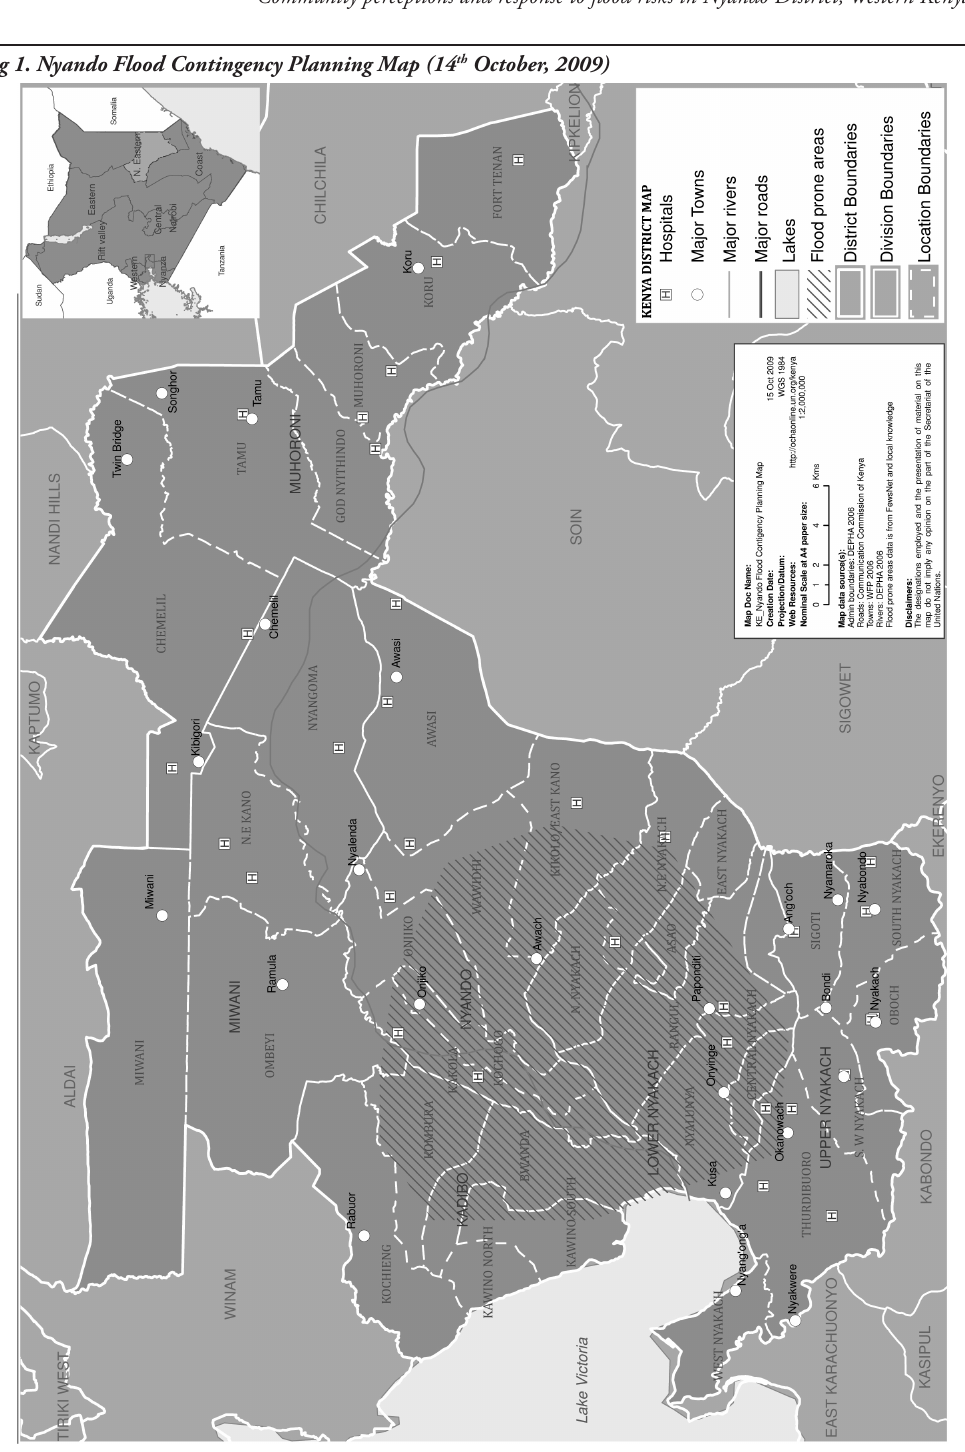
Source: United Nations Office for the Coordinating of Humanitarian Affairs (OCHA) http://www.nyando.org/about/